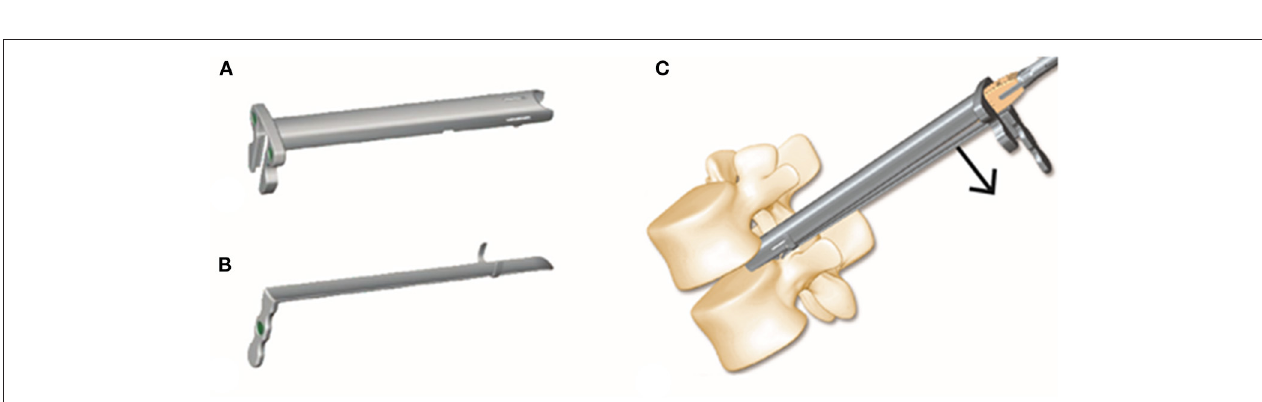
of conventional PEEK implants was difficult during Endo-TLIF expandable cages have been used in most subsequent Endo- expandable cages remains to be further studied. By utilizing this